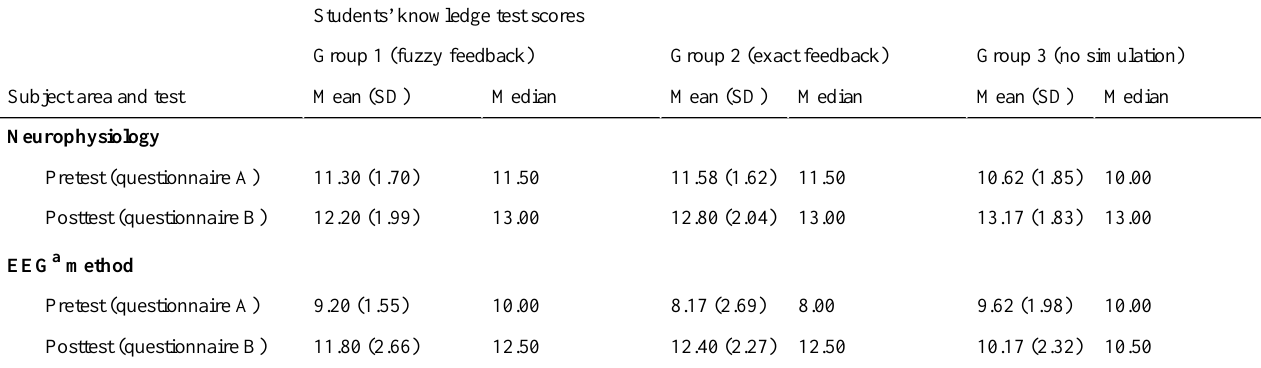
Table 1. Students’pre- and posttest knowledge scores within the